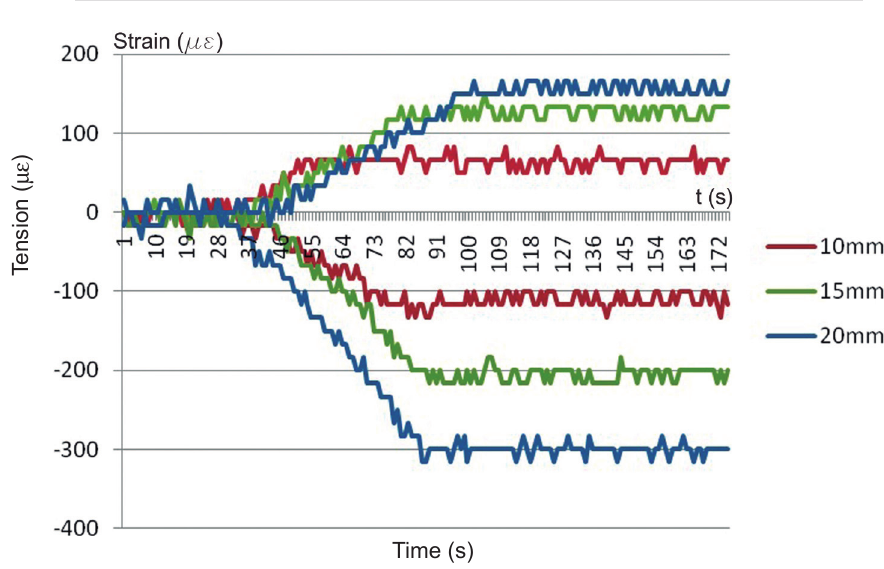
Figure 7- Measurements for tension (positive values) and compression (negative values) in different points of force application for Ceramic group (Ce).